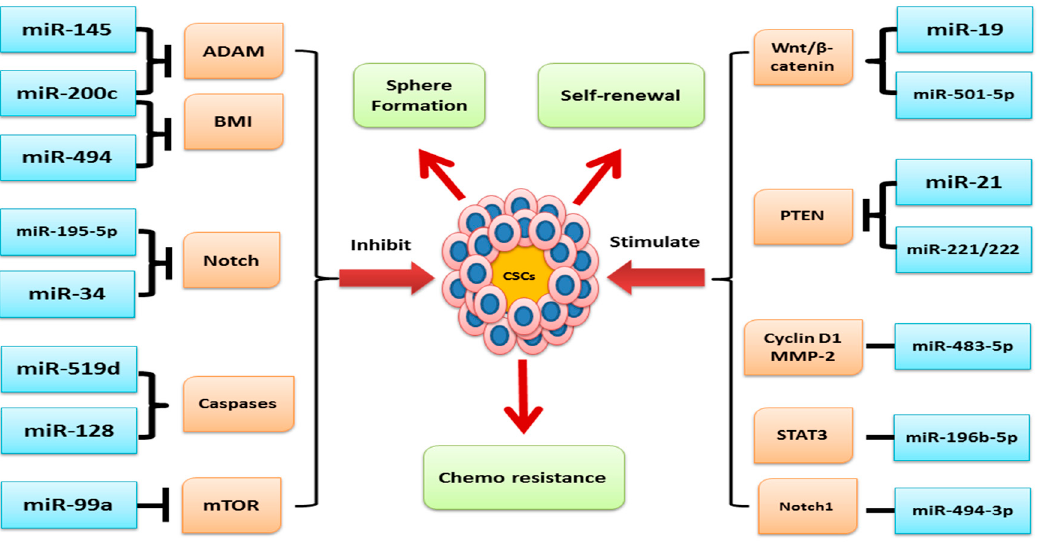
Figure 2. miRNAs in regulating cancer stem cells characteristics: miRNAs can both inhibit or stimulate the development and characteristic of CSCs such as the ability of self-renewal, sphere formation, and chemoresistance through targeting signaling pathways involved in their survival and proliferation. Many miRNAs were found to inhibit CSCs: miR-145 and miR-200c through inhibiting ADAM, miR-494 via BMI, miR-195-5p and miR-34 via inhibiting the Notch1 pathway, and miR-99a through inhibiting mammalian target of rapamycin (mTOR). Conversely, miR-519d and miR-128 inhibit CSCs via activating caspases. On the other hand, miRNAs can stimulate CSCs development: miR-19 and miR-501-5p through activating the wingless (WNT) / β -catenin signaling pathway; miR-21 and miR-221 / 222 via inhibiting phosphatase and tensin homolog (PTEN); and miR-483-5p, miR-196b-5p, and miR-494-3p through activating the Cyclin D1, STAT3, and Notch1 signaling pathways, respectively .